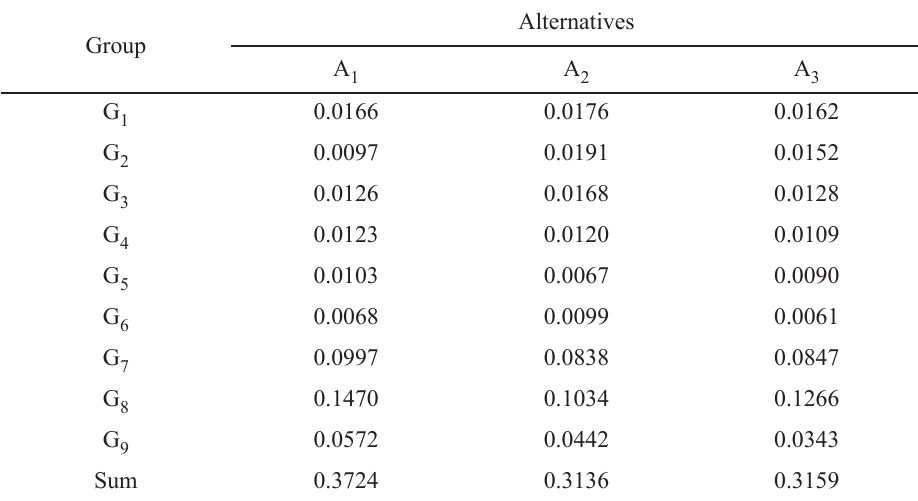
Table 16. Results of competitive strategy alternatives